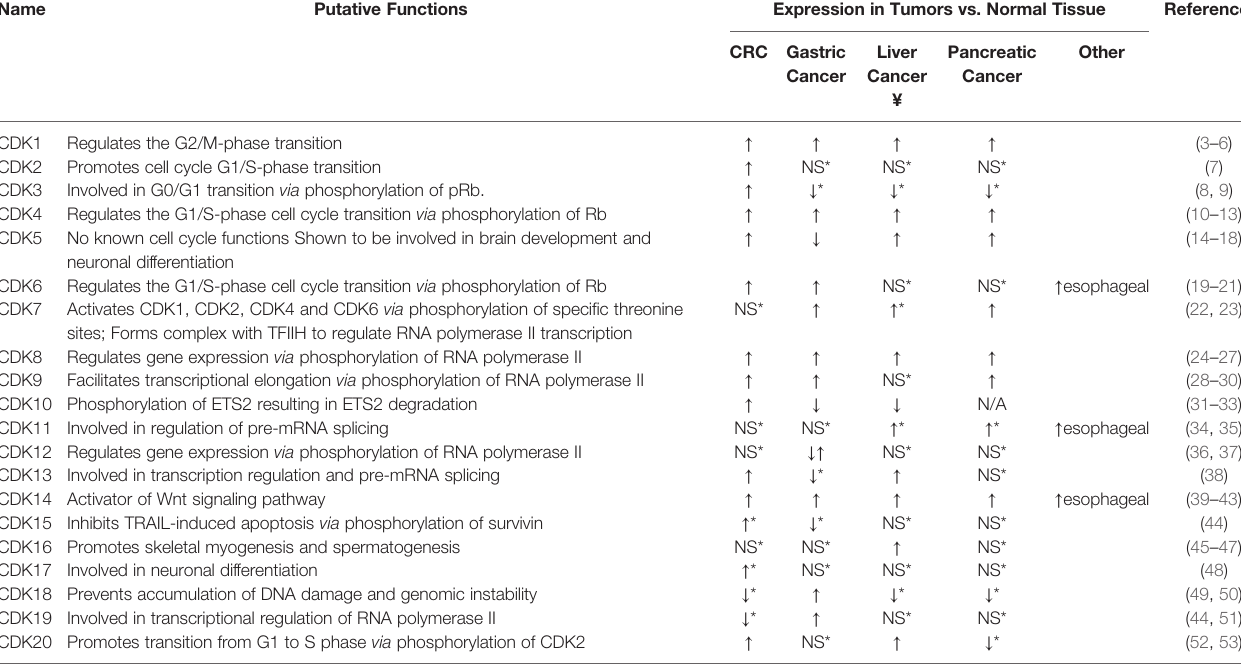
TABLE 1 | CDKs in gastrointestinal